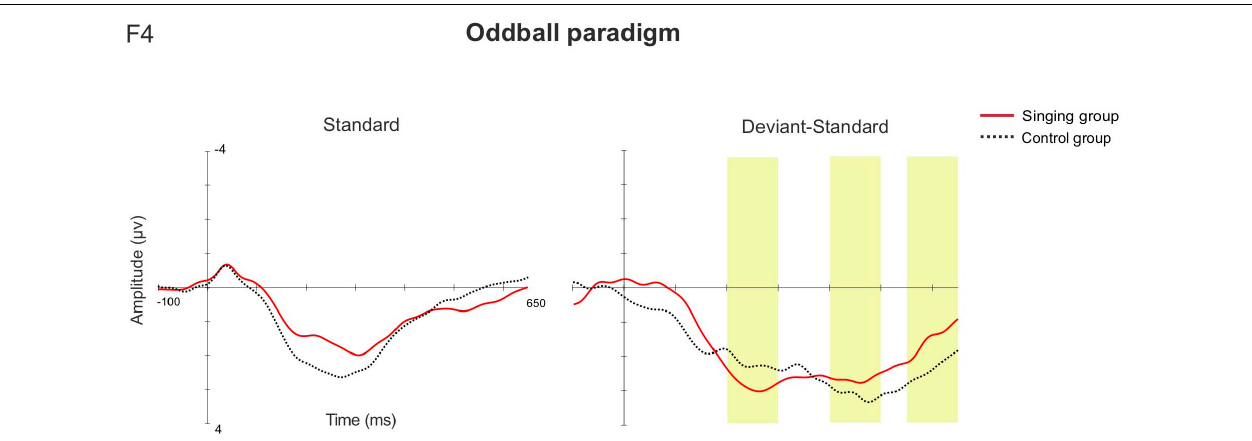
Frontiers in Neuroscience |